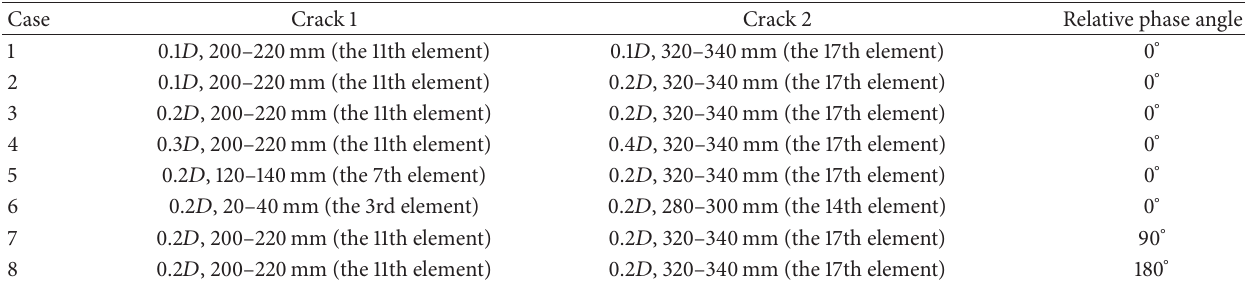
Table 2: Cases of the rotor with cracks of varying depths at different